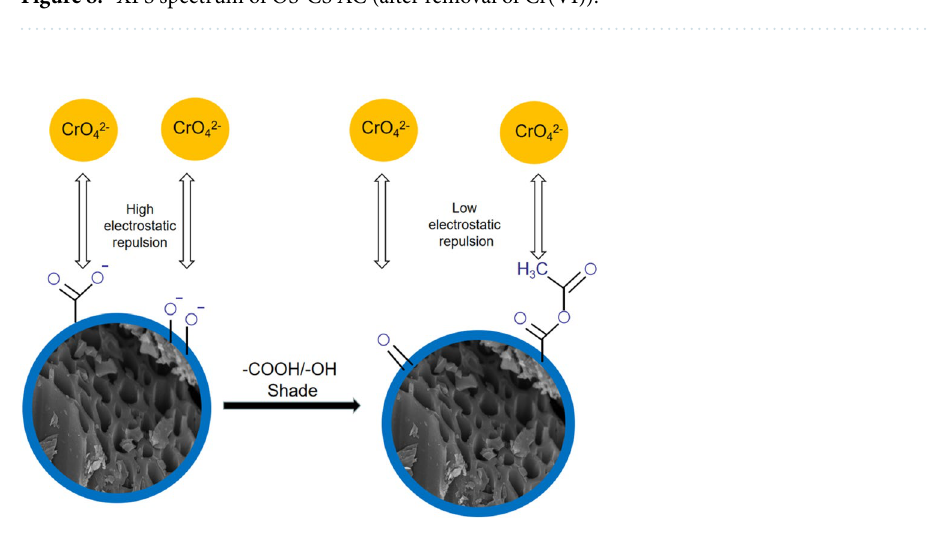
Figure 9. Hydroxy carboxyl group masking